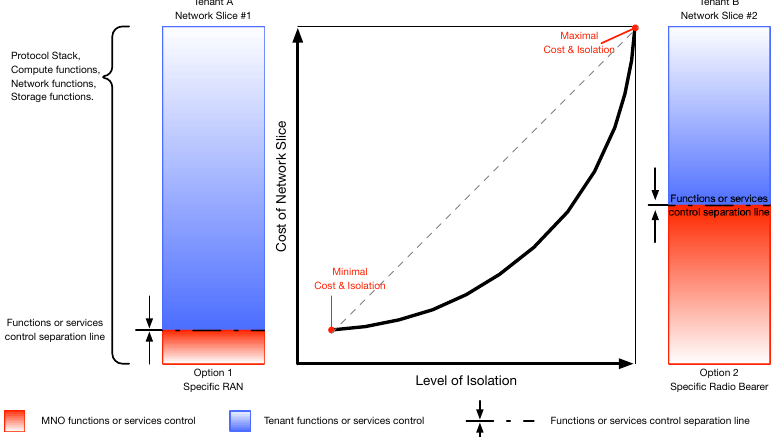
Figure 2. The network slice’s cost rises with the isolation level due to the additional implementation of tenant-dedicated functions and service